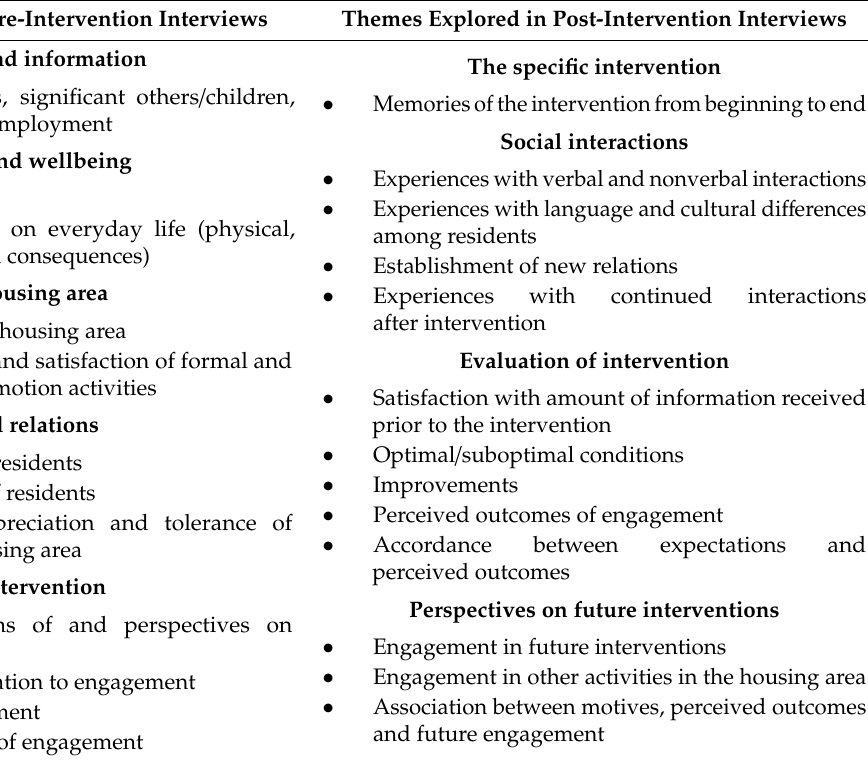
Table 2. Themes included in observation and interview